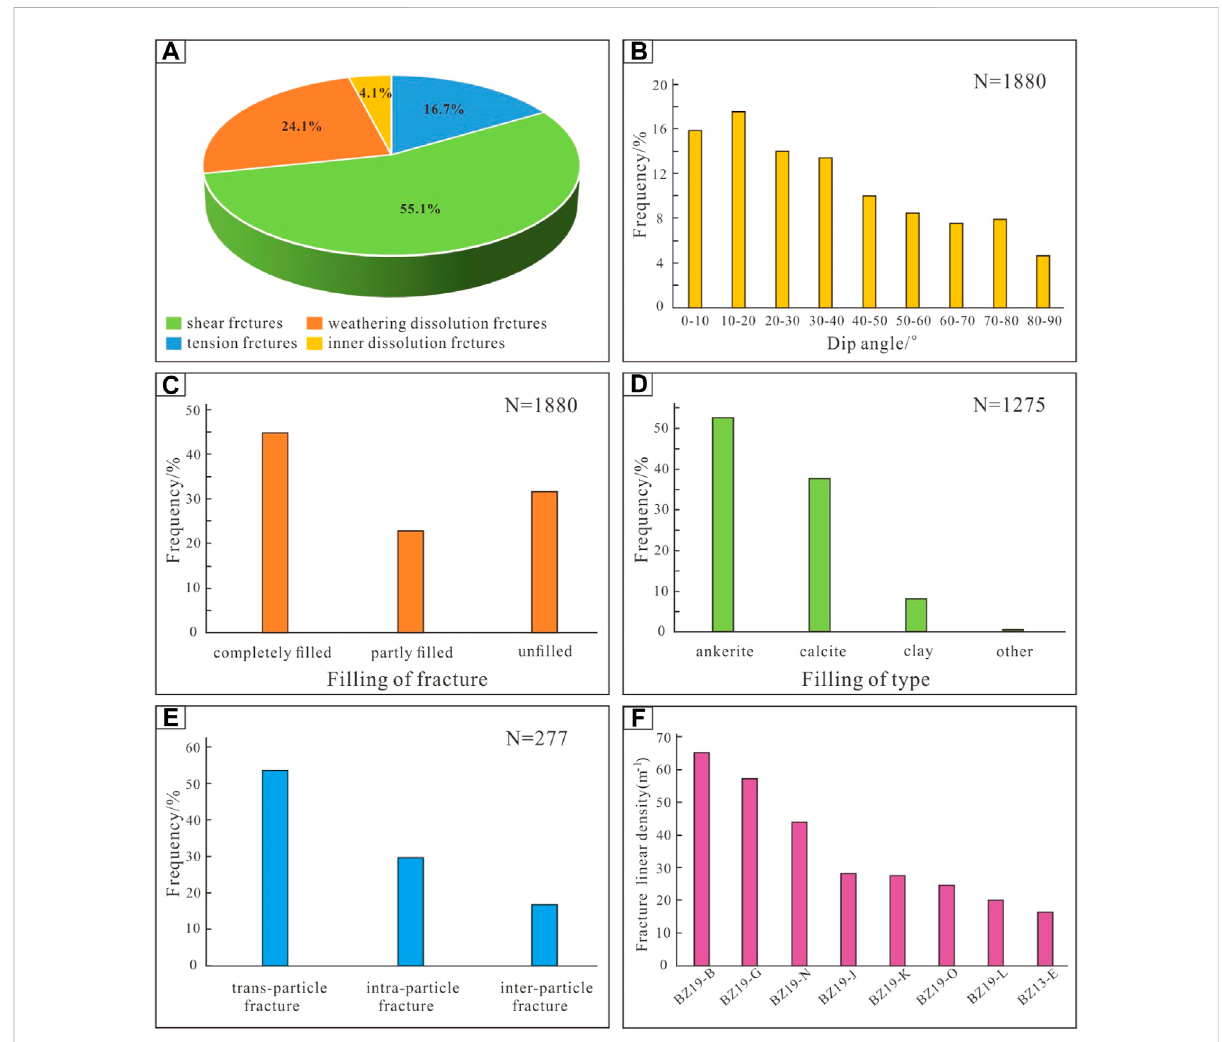
FIGURE 5 Statistical plot of the characteristic parameters of the fractures. (A) Statistical results of fracture types in cores; (B) Frequency distribution of fracturedipangleincores; (C) Frequencydistributionoffracture fi llingstypesincores; (D) Frequencydistributionoffracture fi llingmaterialsincores; (E) . Frequency distribution of microfractures types in thin sections; (F) Fracture density of cores in coring